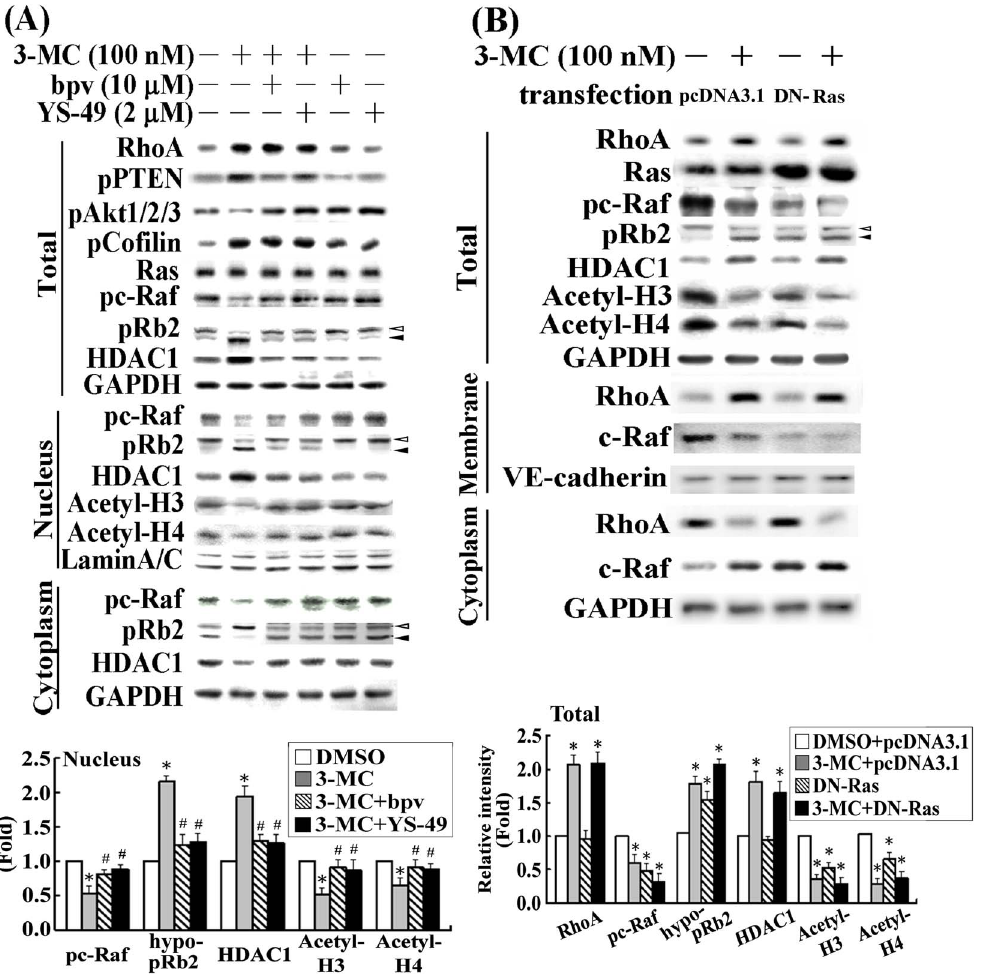
Figure 4. Involvement of PTEN and PI3K in pRb2 hypophosphorylation induced by Ras/c-Raf inactivation. (A) Cells were pretreated with bpv (an inhibitor of PTEN) for 30 min or YS-49 (an activator of PI3K) for 1 h, followed by 1 h of 100 nM 3MC treatment. Total cell lysates, and extraction of nuclear and cytosolic proteins were analyzed using Western blot analysis for related signaling molecules involved in chromatin deaceylation. (B) Cells were transfected with a plasmid containing the DNRas gene to mimic the effect of 3MC. After 1 h of 3MC treatment, cells were harvested for Western blot analysis of the mentioned molecules in total and cytosolic-membrane extracts. GAPDH, Lamin A/C, and VE-cadherin were used as internal controls for the cytosol (or total), nuclear and membrane fractions, respectively, to verify equivalent loading. The lower panel shows the intensity of bands in the Western blots using densitometry. Data are presented as mean 6 SEM of 3 independent experiments (* P , 0.05 vs. control group; # P , 0.05 vs. 3MC treatment